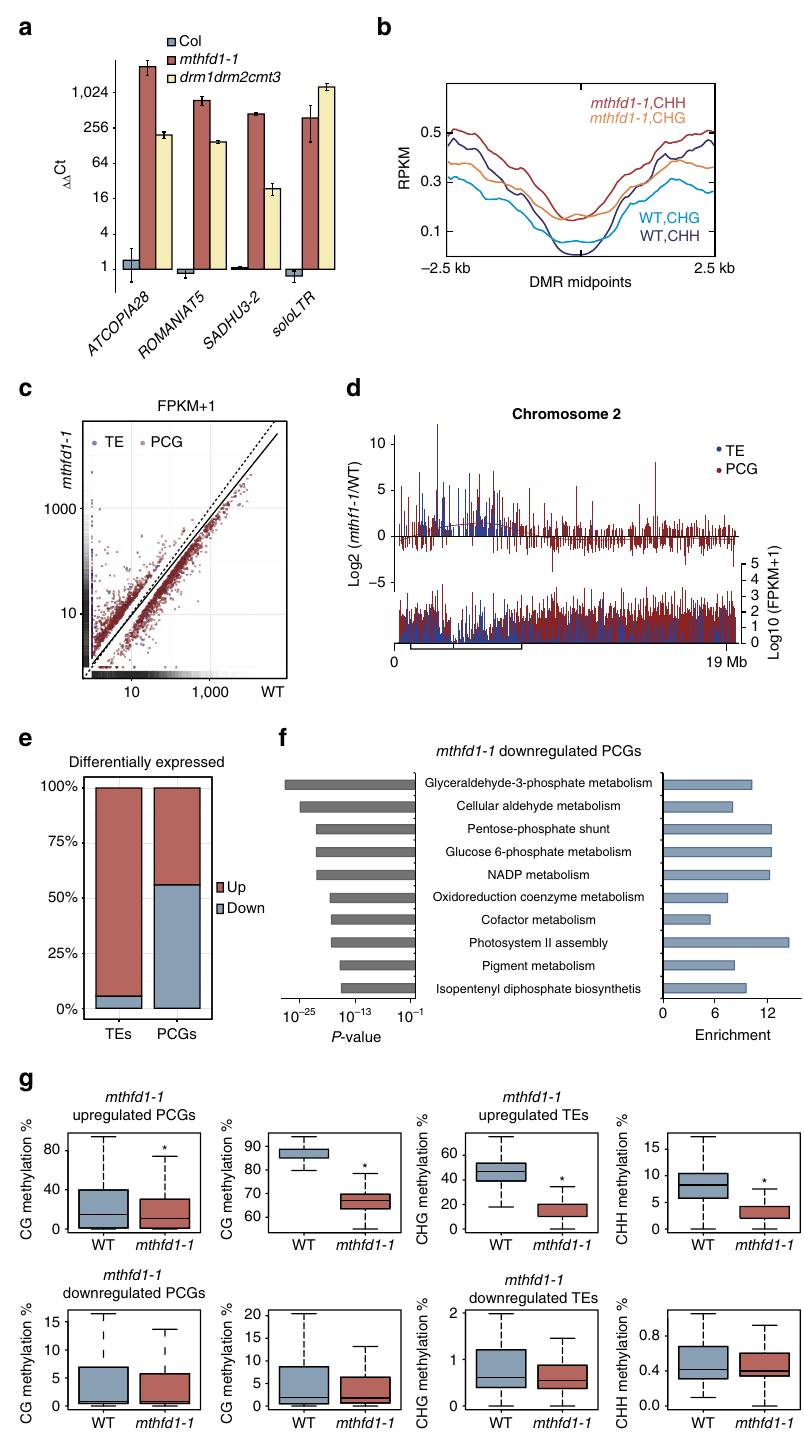
Figure 4 | mthfd1-1 mutants show loss of TE silencing and pleiotropic transcriptional deregulation of PCGs. ( a ) Quantitative RT-PCR analysis of four exemplary TEs. Transcript levels are normalized to ACTIN7 and relative to WT, and mean values ± s.e.m. ( n ¼ 3) are shown. ( b ) Average distribution of normalized RNA-seq reads (RPKM) over mthfd1-1 hypo-DMRs in CHG or CHH context. X axis indicates distance from the DMR midpoints. ( c ) Scatter plot showing normalized transcript levels (FPKM þ 1) of differentially expressed PCGs and TEs in mthfd1-1 versus WT. Solid line: linear regression through all TEs and PCGs. Dashed: identity line. Marginal density plots: distribution of all TEs and PCGs in WT ( x axis) and mthfd1-1 (y-axis). ( d ) Distribution of average normalized transcript levels (FPKM þ 1) of all TEs and PCGs from mthfd1-1 and WT (lower panel) and fold change in normalized transcript levels of differentially expressed PCGs and TEs (upper panel) along chromosome 2. Box and vertical line inside box mark pericentromeric region and centromere, respectively. ( e ) Fraction of TEs and PCGs significantly up- or downregulated in mthfd1-1 . ( f ) Enrichment score and statistical significance of GO processes annotated to mthfd1-1 -downregulated PCGs. ( g ) Methylation levels over mthfd1-1 differentially expressed PCGs and TEs in different sequence